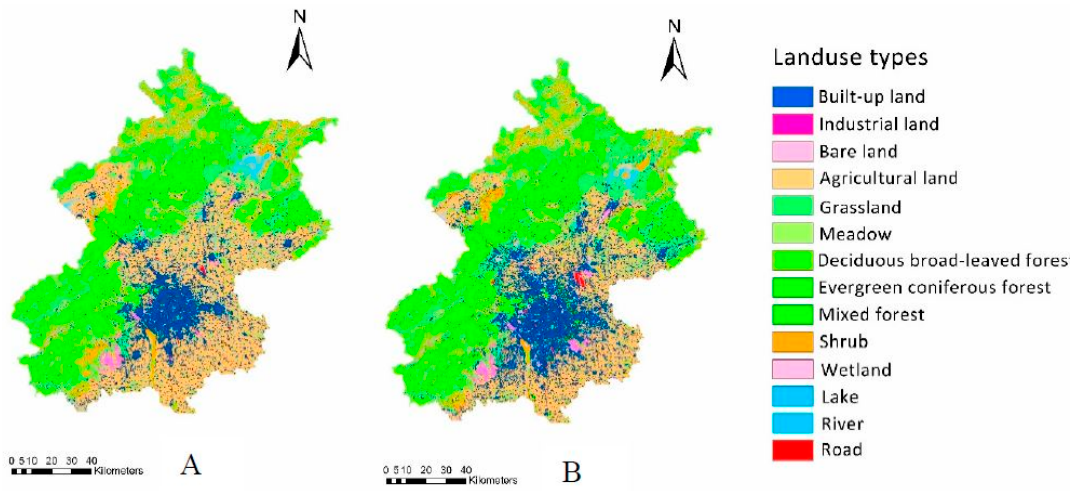
Figure 2. The land uses in: 2000 ( A ); and 2012 ( B ).